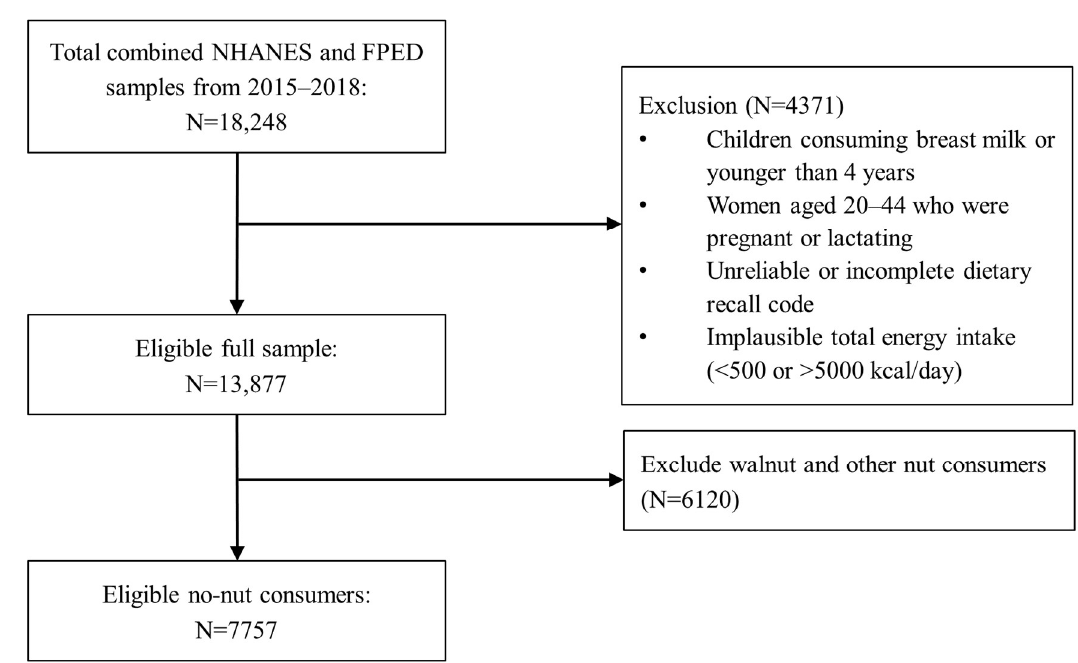
Figure 1. Flow chart of the sample selection from the NHANES 2015–2018.